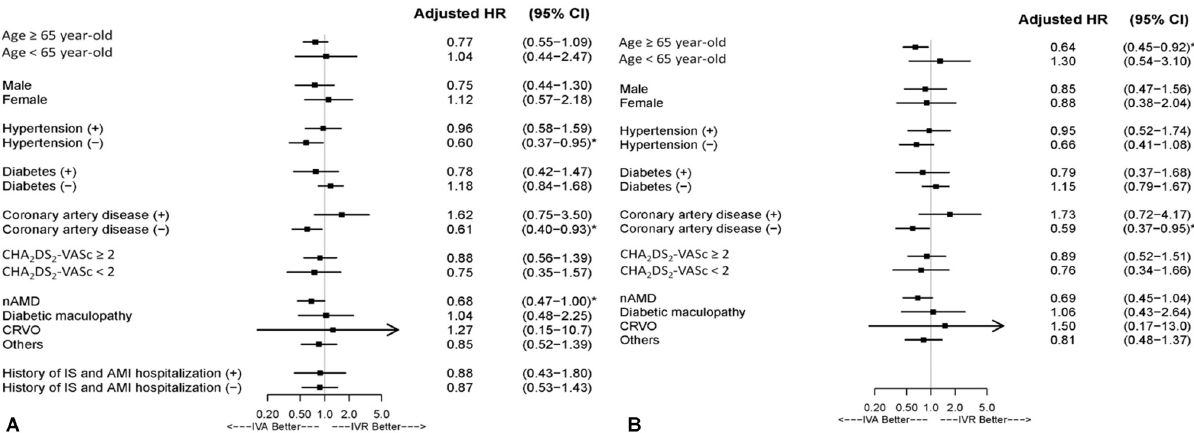
Fig 3. Subgroup Analysis of Adjusted HR of ATEs (IS or AMI Hospitalization) of patients receiving IVA injection compared with those receiving IVR injection: (A) Overall Cohort (B) Cohort without a history of AMI or IS. AMI = acute myocardial infarction; ATE = arterial thromboembolic event; HR = hazard ratio; IS = ischemic stroke; IVA = intravitreal aflibercept; IVR = intravitreal